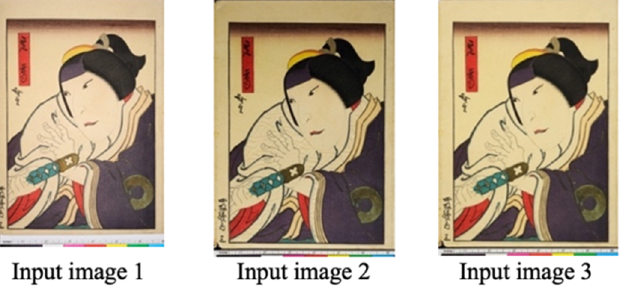
Figure 17. The same ukiyo-e print that was digitized at the different institutions. Table 10. Similarity between image pairs in the IMGonline and DeepAI application.